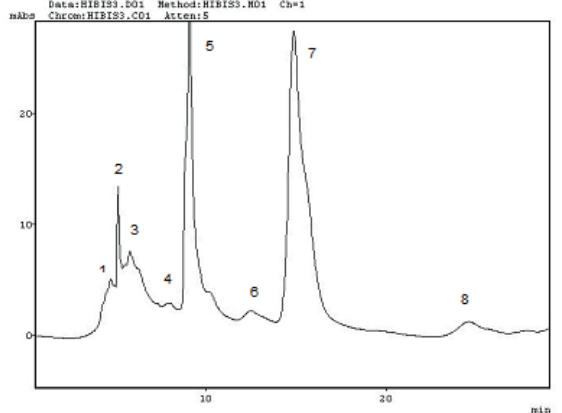
Figure 1 - Chromatographic profiles of phenolic compounds of H. acetosella extracts (HPLC, 280 nm). Peak 1: gallocatechin; 2: unidentified compound; 3: gallic acid; 4: 3,4-dihydroxybenzoic acid; 5: unidentified compound; 6: